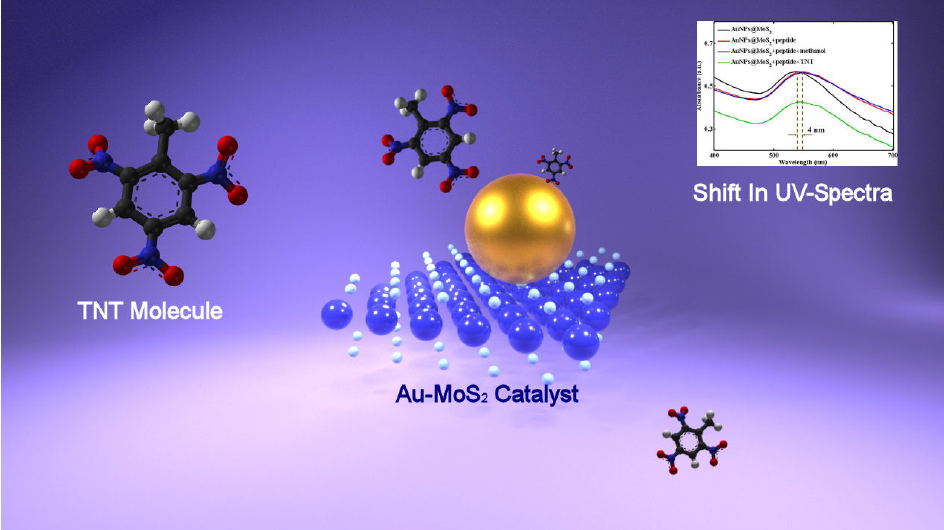
Figure 5. TNT sensing by monitoring the shifts of LSPR peak in the UV spectra.